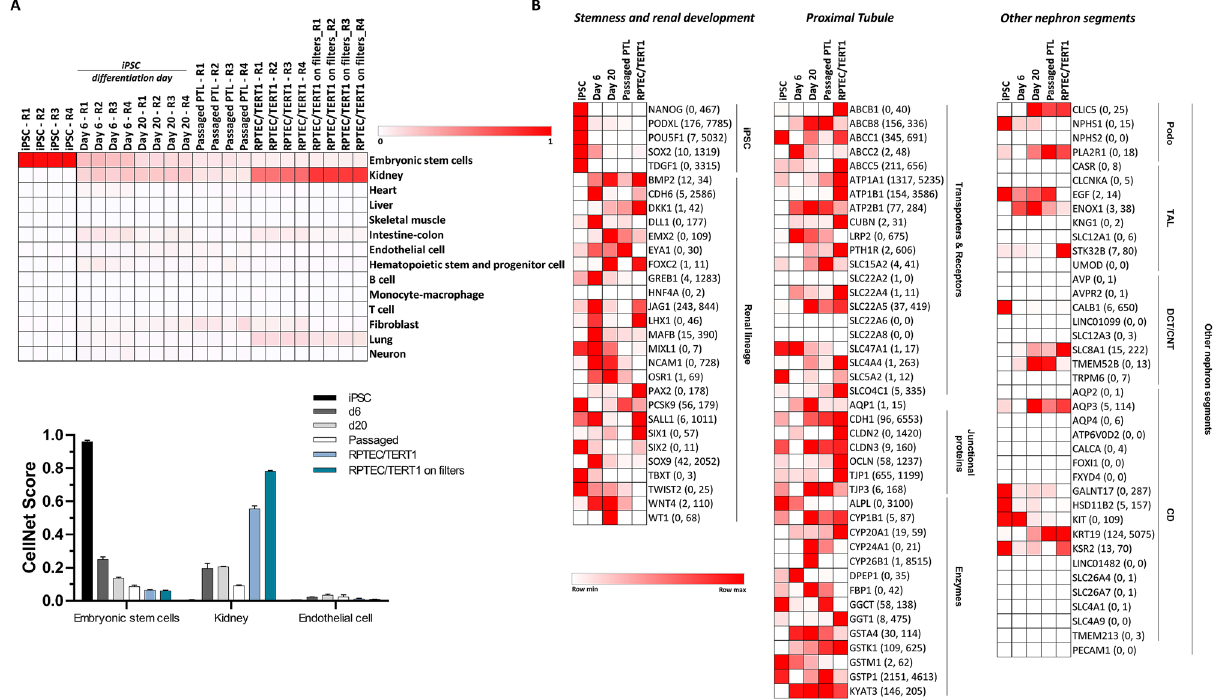
Figure 2. Heat map representation of mRNA expression quantified by RNASeq from selected genes in iPSC, PTL differentiations and RPTEC/TERT1 cells. iPSCs (SBAD3) were differentiated into PTL on ECM for 20 days. RNASeq analysis was performed on samples collected from undifferentiated iPSC, day 6 and 20 after differentiation and PTL passaged at day 16 of differentiation and cultured for 4 additional days after passaging. RPTEC/TERT1 cells were used for comparison. Results are presented for 4 independent replicates (R1 to R4). Heatmaps were generated by Microsoft Excel 365 conditional formatting with a 2-scale colour system (white (low) to red (high)). ( A ) CellNet (Cahan et al . 2014) was used to compare sample transcripts with existing tissue data bases. The higher the similarity, the higher the score. Scaling is conducted across all samples and tissues. The mean CellNet score ± standard deviation is plotted in the graph. ( B ) Heat maps represent read count expression. The abbreviation represents the official gene symbol. The different gene subsets are sorted in alphabetical order. Minimum and maximum normalised read counts are given in parenthesis. Scaling is conducted per